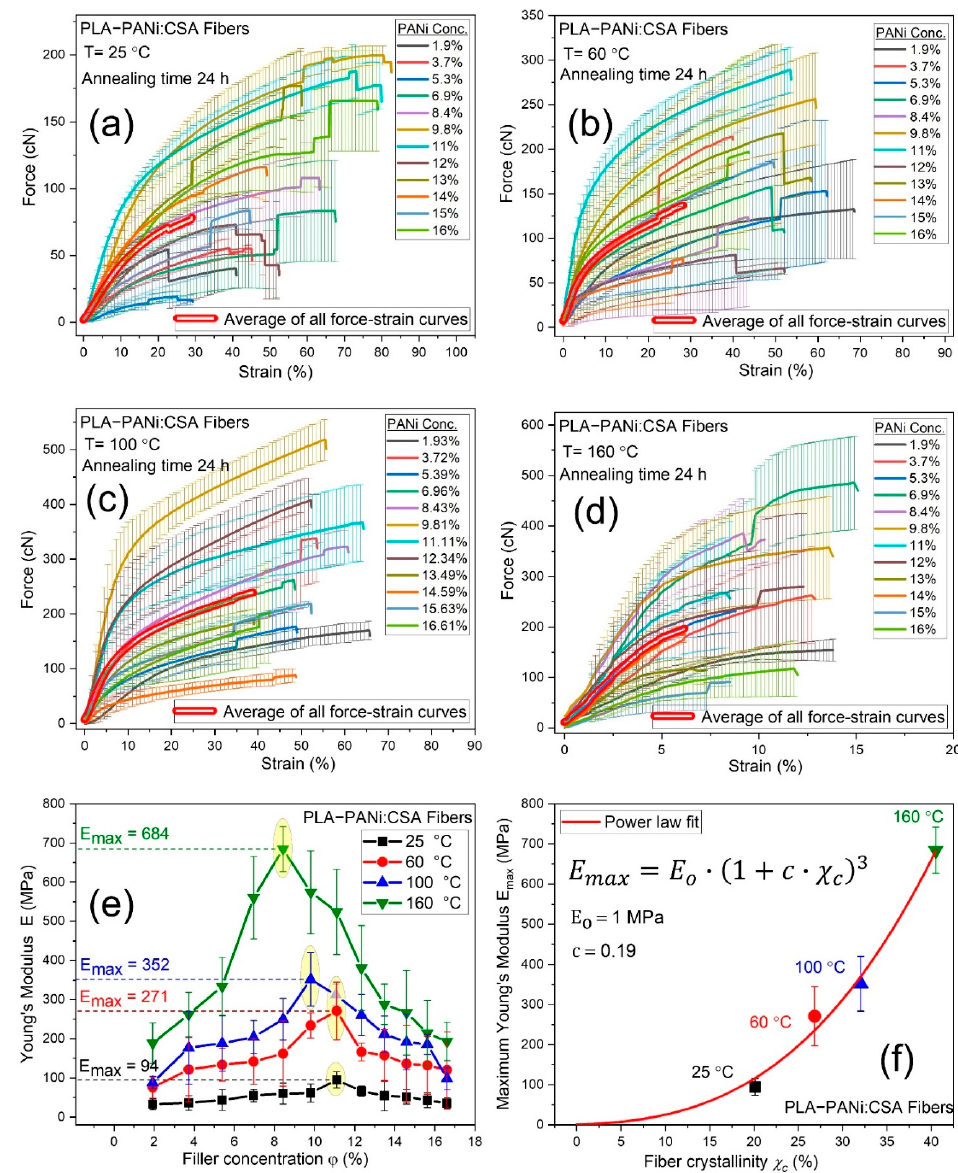
Figure 6. ( a – d ) show the force-strain curves for PLA-PANi:CSA fibers using 25, 60, 100, and 160 ◦ C annealing temperatures, respectively. The percentage volume fraction ( ϕ % ) of PANi varies from 0% to 16%. The bold double red lines (in ( a – d )) represent the average of all force-strain curves with common X range. ( e ) shows elastic Young’s modulus E as a function of percentage volume fraction ( ϕ % ) of PANi for PLA-PANi:CSA fibers at 25, 60, 100, and 160 ◦ C annealing temperatures. ( f ) shows a power law correlation between maximum Young’s modulus E max and fiber crystallinity χ c